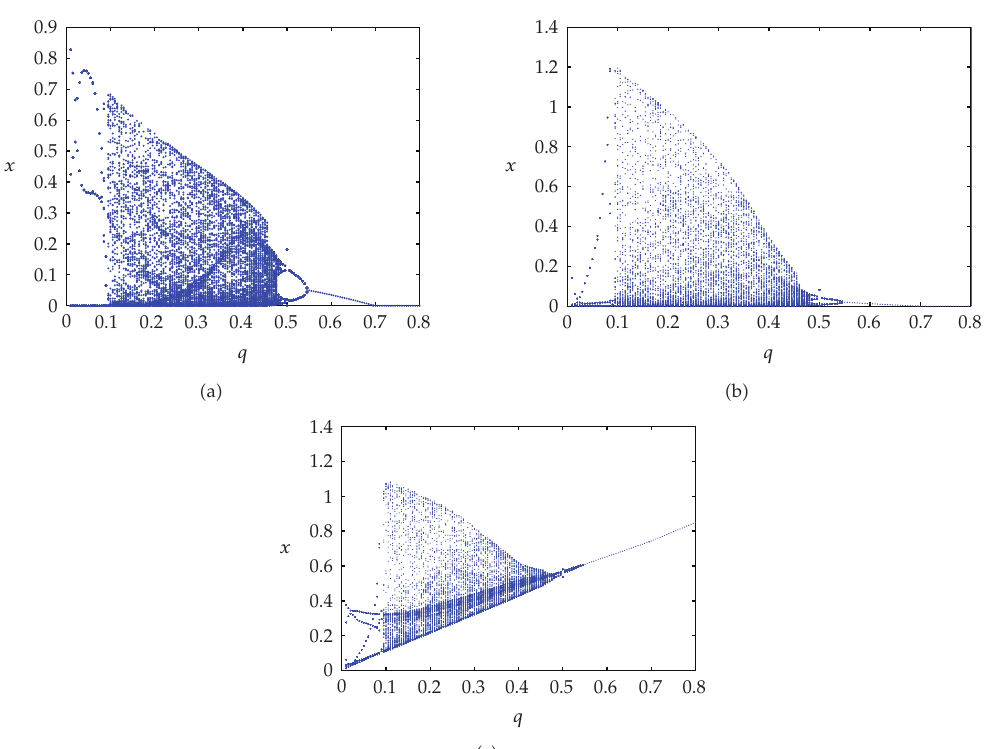
Figure 6: Bifurcation diagrams of system (cid:2) 1.1 (cid:3) showing the e ff ect of q with r (cid:6) 1 , a (cid:6) 1 , b (cid:6) 4 , k (cid:6) 2 , m (cid:6) 0 . 8 , D (cid:6) 0 . 4 , v 1 (cid:6) v 2 (cid:6) 0 . 2 , l (cid:6) 0 . 5 , δ (cid:6) 0 . 1 , δ 1 (cid:6) 0 . 5 , δ 2 (cid:6) 0 . 1 , T (cid:6) 13 . 7 , 0 . 01 ≤ q ≤ 0 . 8 and initial values x (cid:6) 8 . 5 , y 1 (cid:6) 4 . 8 , y 2 (cid:6) 2 . 8.